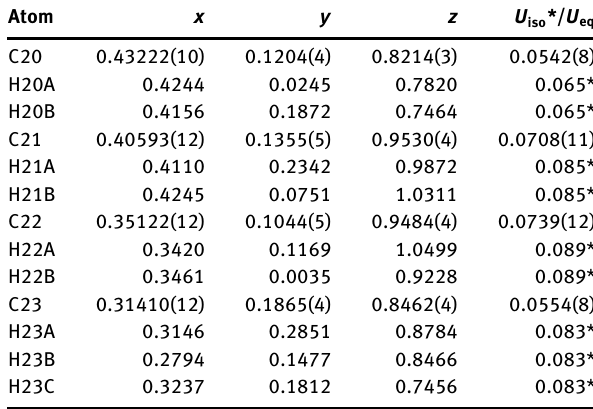
Table 2: Fractional atomic coordinates and isotropic or equivalent isotropic displacement parameters (Å 2